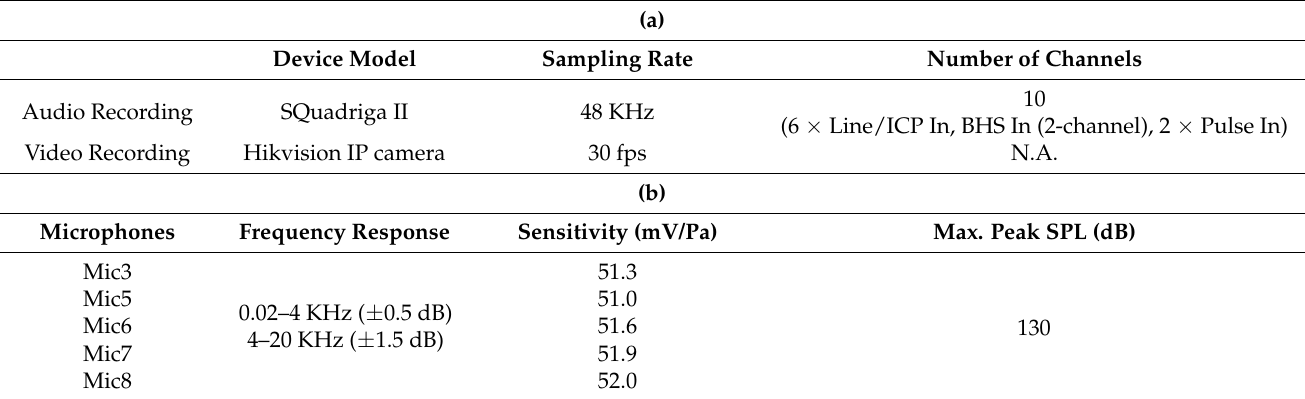
Figure 7. The audio recording setup: ( a ) indication of microphone locations; ( b ) picture of instruments used for audio recording. Table 1. Technical details of recording devices: (a) info of audio and video recorders: (b) info of microphones.